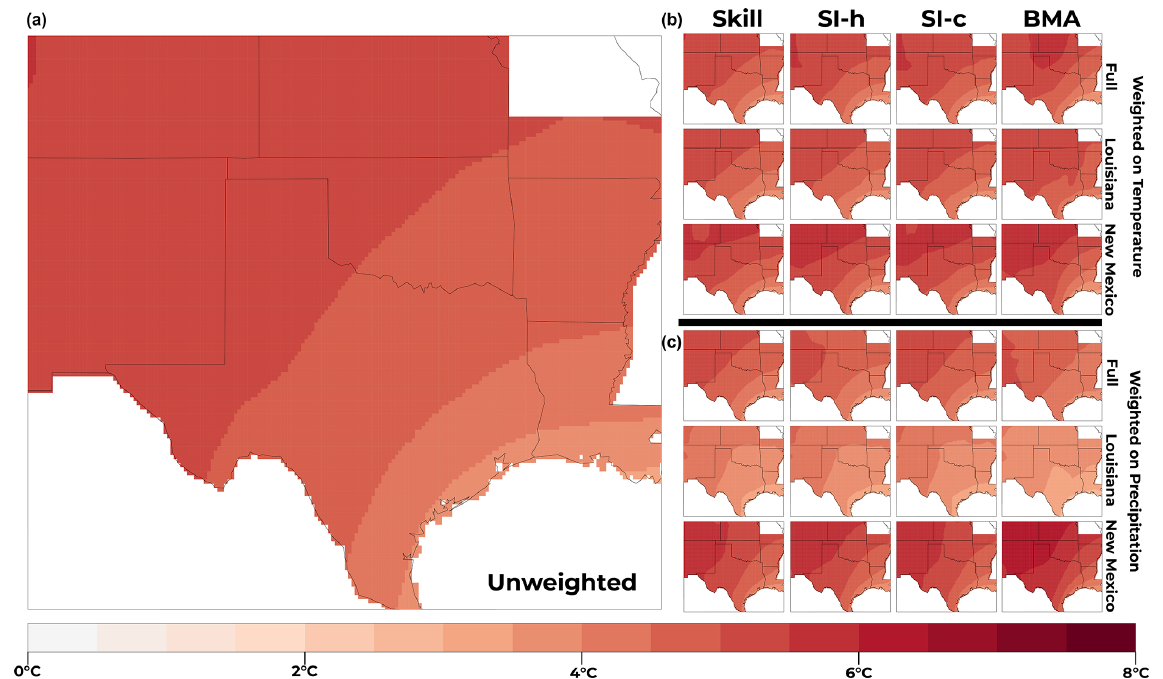
Figure 11. Same as Fig. 9, but for the mean projected change in high temperature from the CMIP5